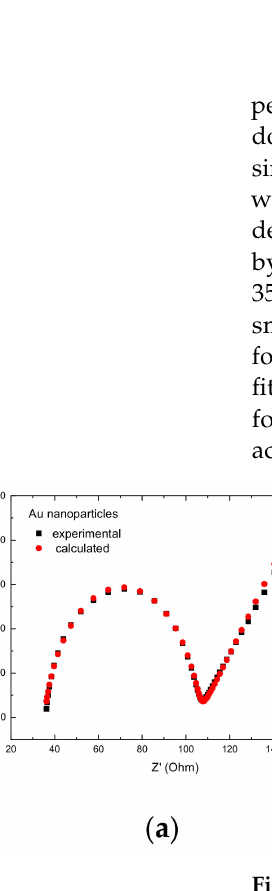
Figure 7. Nyquist plots for symmetrical thin layer cell. Electrode Spacing ~100 µ m: ( a ) Au nanoparti- cles; ( b ) Au film; ( c ) equivalent circuit for the symmetric